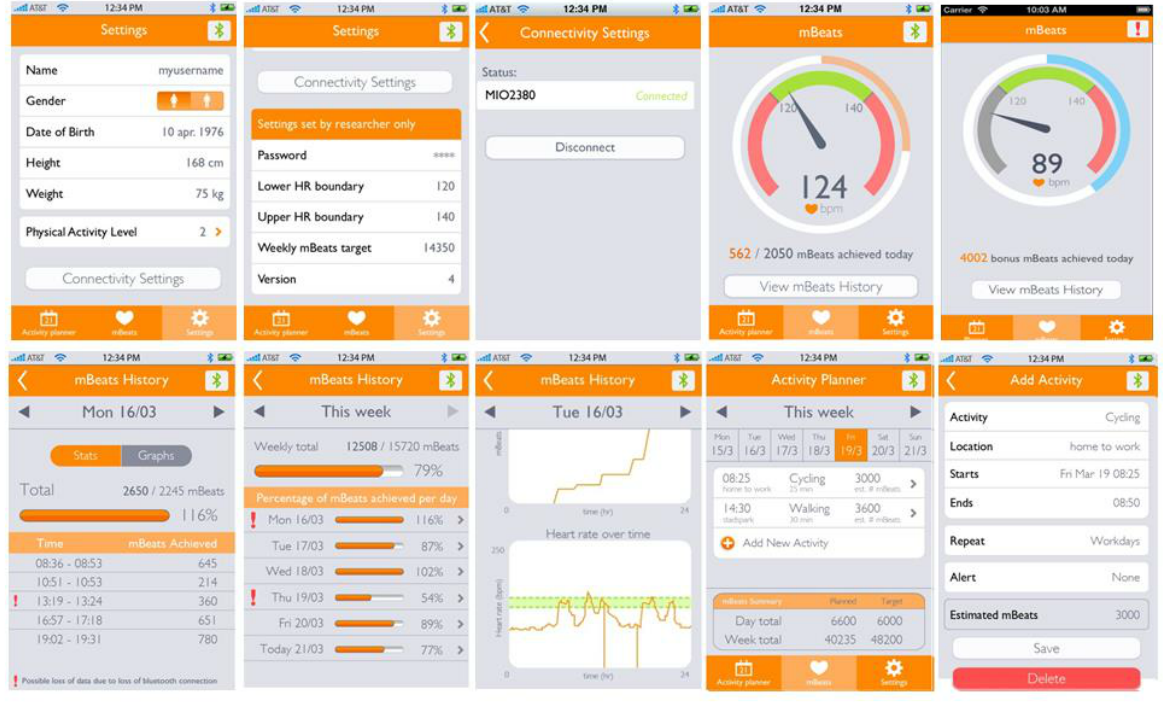
Figure 3. Multiple screenshots of the Cardio Fitness mobile app used in this